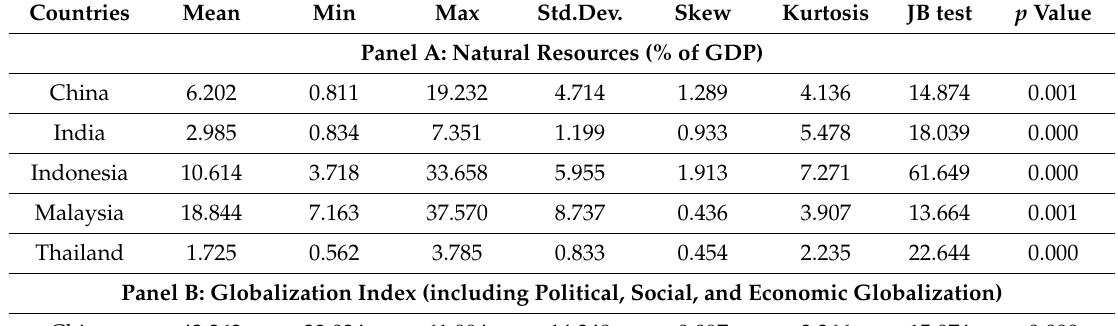
Table 1. Results of descriptive statistics for top Asian